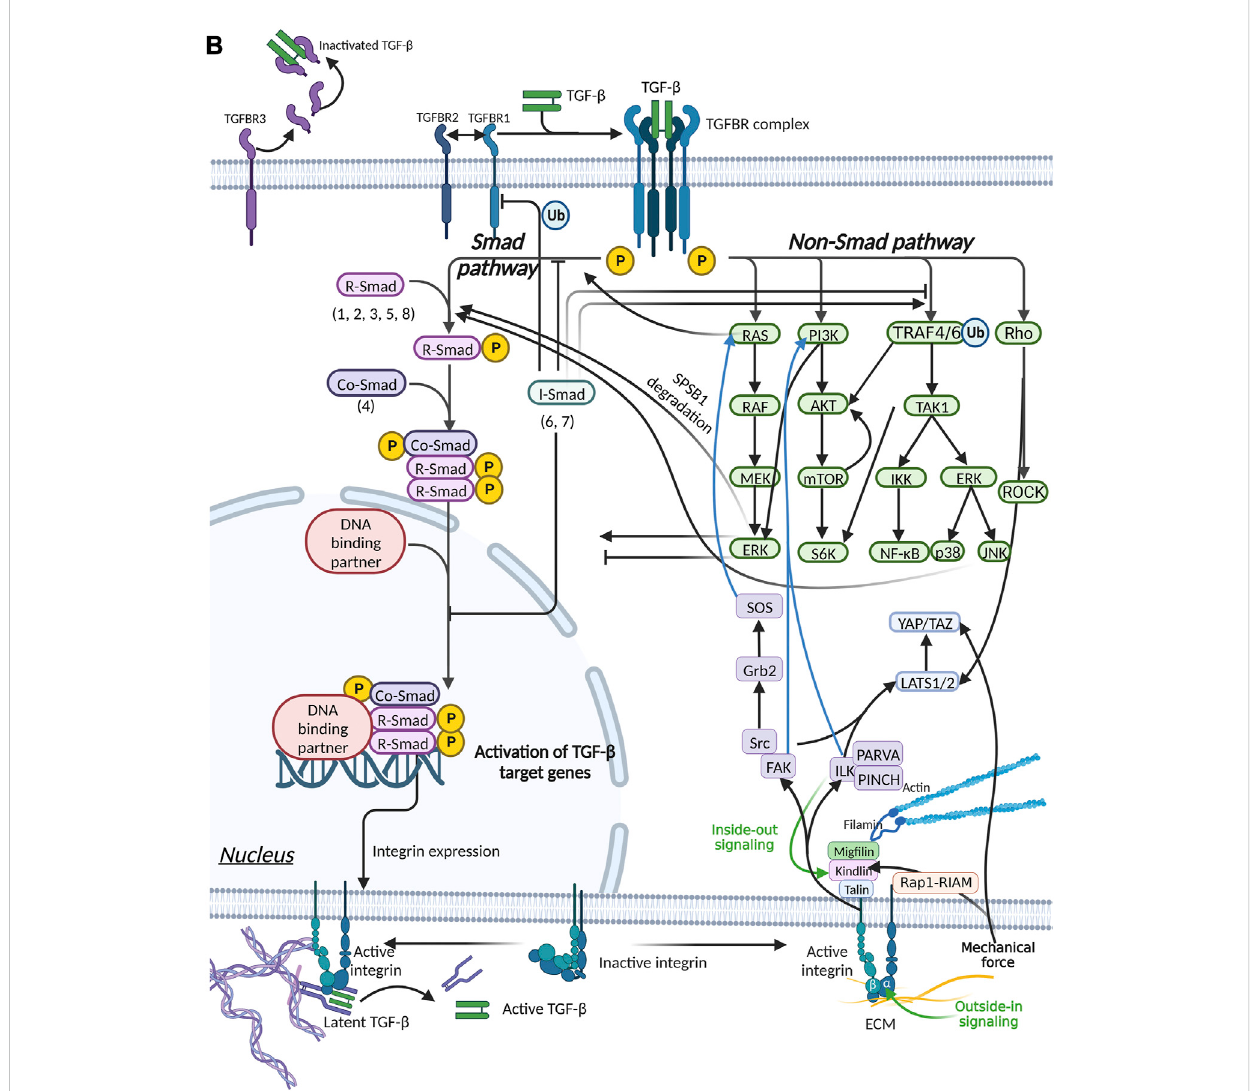
FIGURE 5 (contiuned) Integrin, Hippo and TGF- β signaling pathways mediate mechanical stress signaling to the cell. (A) TGF- β is secreted out of cells in an inactive form. Activated TGF- β can upregulate ECM stiffness through fi broblast activation. (B) Mechanical signals are involved in TGF- β activation.The interaction of activated TGF- β and TGFBR mediated thetransmembranetransduction of ECM mechanical signals, which is transduced via two pathways, Smad and non-Smad, thereby regulating myo fi broblast differentiation and the stiffness of the ECM. Integrins can signal through pathways such as FAK, ILK and Hippo, and there is crosstalk with the TGF- β